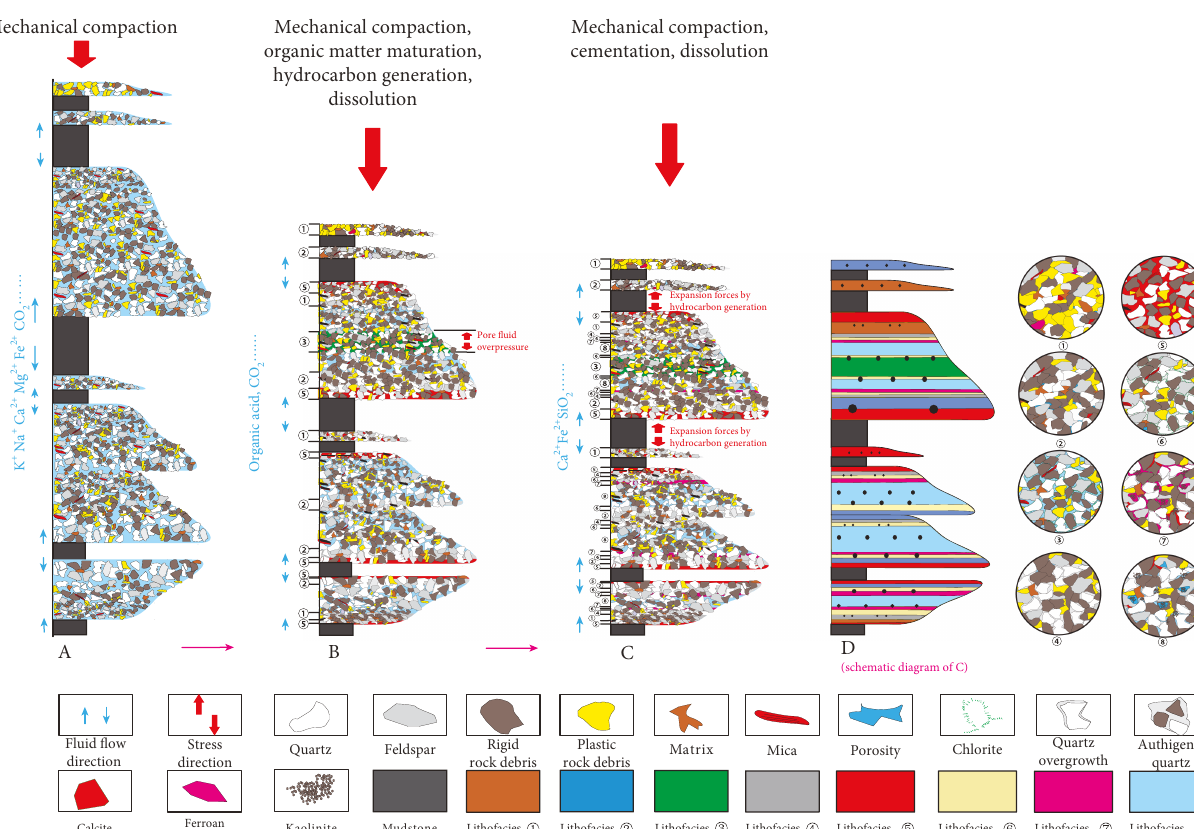
Figure 15: Diagram of di ff erential sandstone densi fi cation mode forming